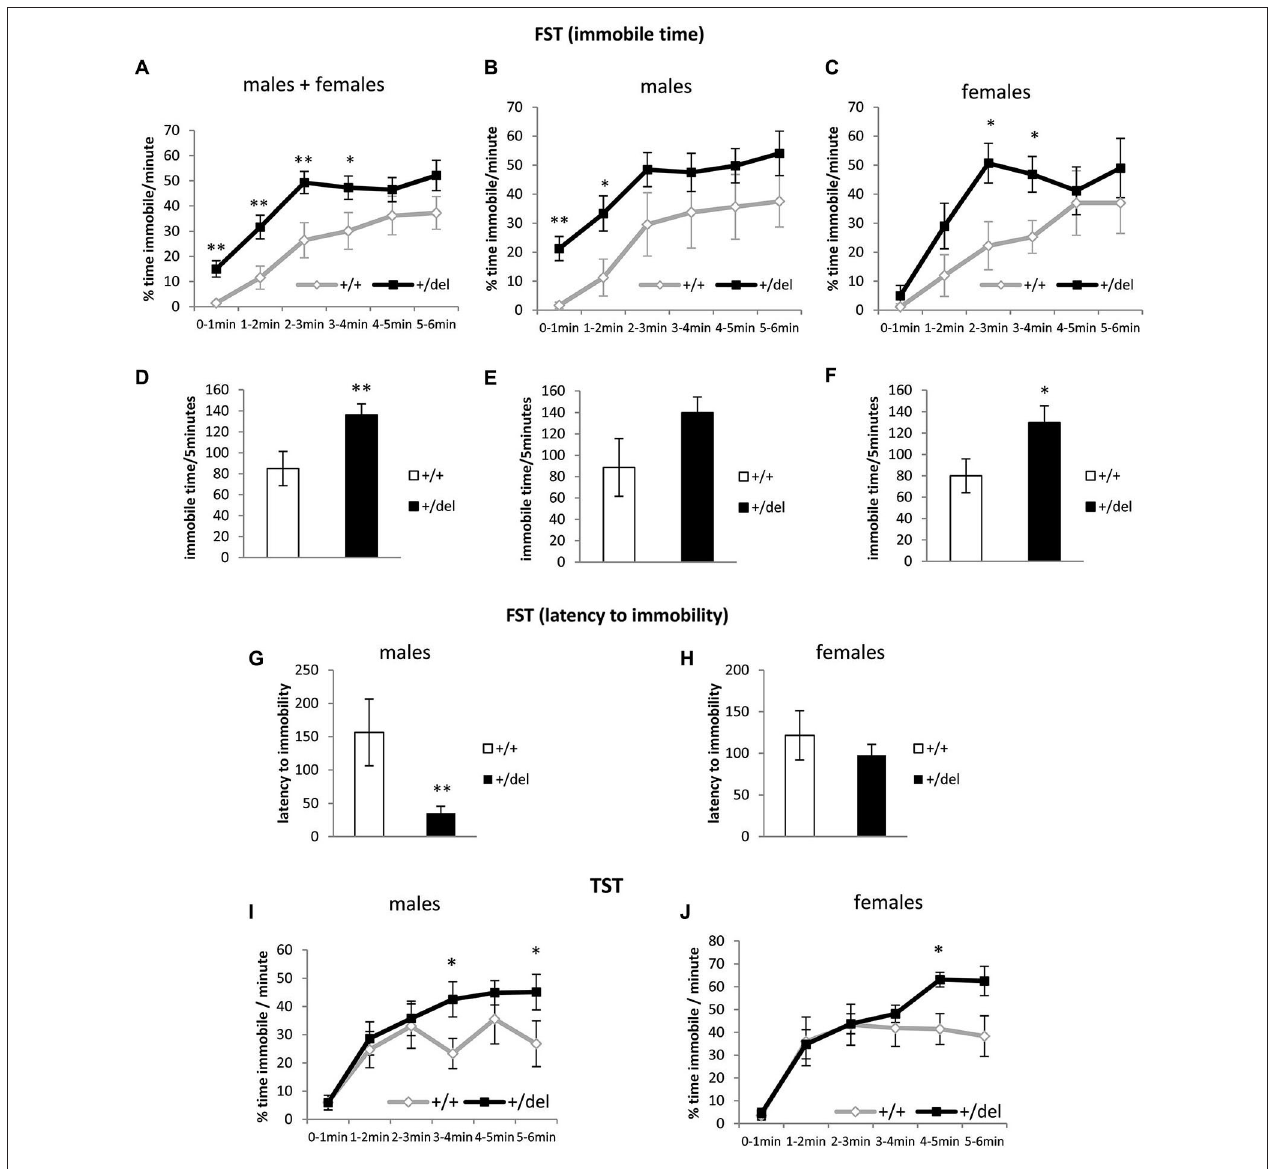
3 s). Males and females ( n + / + = 14, n + / del = 26; left panels), males ( n + / + = 8, n + / del = 16; central panels) and females ( n + / + = 6, n + / del = 10; right panels). (I–J) Performance in TST represented as % of time immobile per minute over the whole 6-min trial. Males ( (I) ; n + / + = 12, n + / del = 15) and females ( (J) ; n + / + = 8, n + / del =